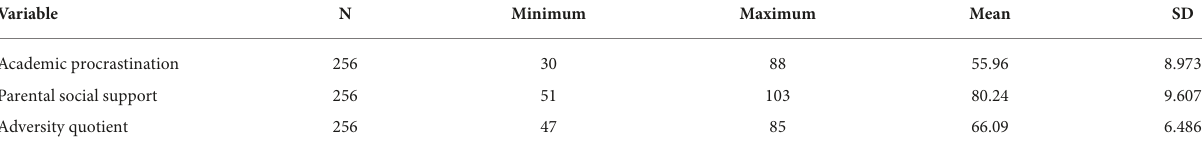
TABLE 1 Descriptive data of the variables.